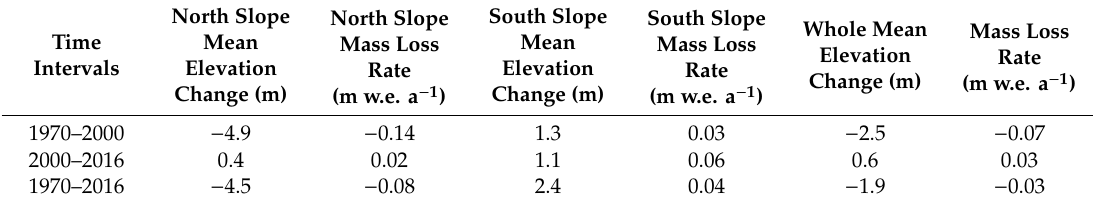
Table 3. The surface elevation change from 1972 to 2016 in